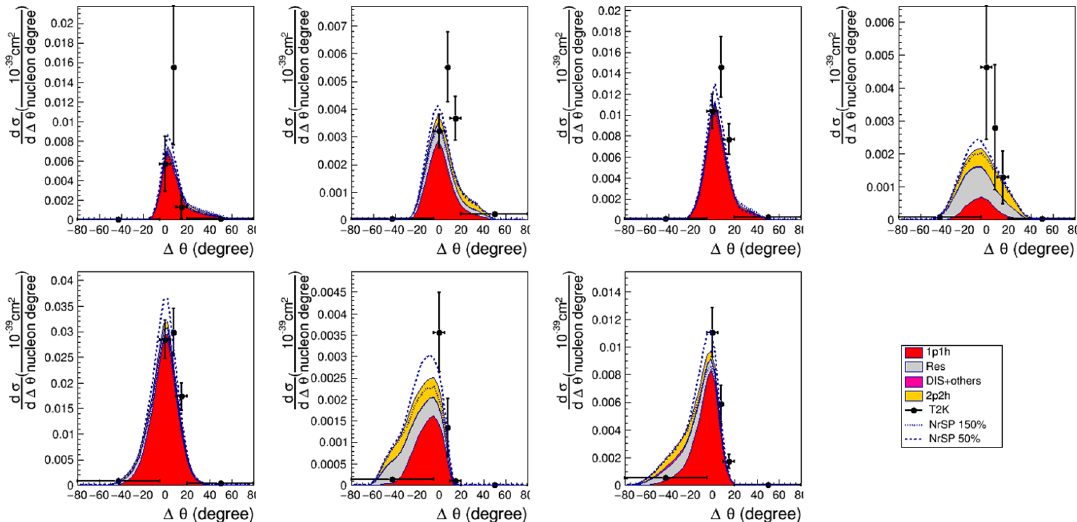
Figure 16 . T2K CC0 π 1p | ∆ θ | distribution. The panels correspond to the muon kinematic bins specified in figure 15. Data taken from [21].